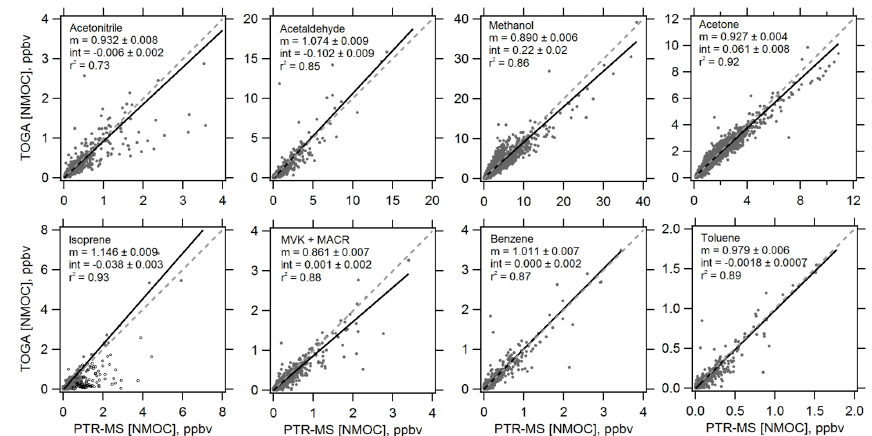
Fig. 1. Comparisons between all ARCTAS TOGA and PTR-MS observations for co-measured NMOCs. Solid lines are ODR fits to the data, with slope and intercept (with 1 σ standard deviations) shown on each plot. Dashed lines show y = x . As well, the r 2 value for the standard linear-regression best-fit has been included on each plot. For isoprene, only data identified as non-BB (grey points, i.e.: not listed in Table 1) are used for the ODR, as PTR-MS isoprene is reported as a sum with furan, which is present in BB. BB data are shown as black circles; using all ARCTAS isoprene data including BB data, the ODR fit has slope 0.76 ± 0.01 and intercept − 0.036 ± 0.006 ppbv.